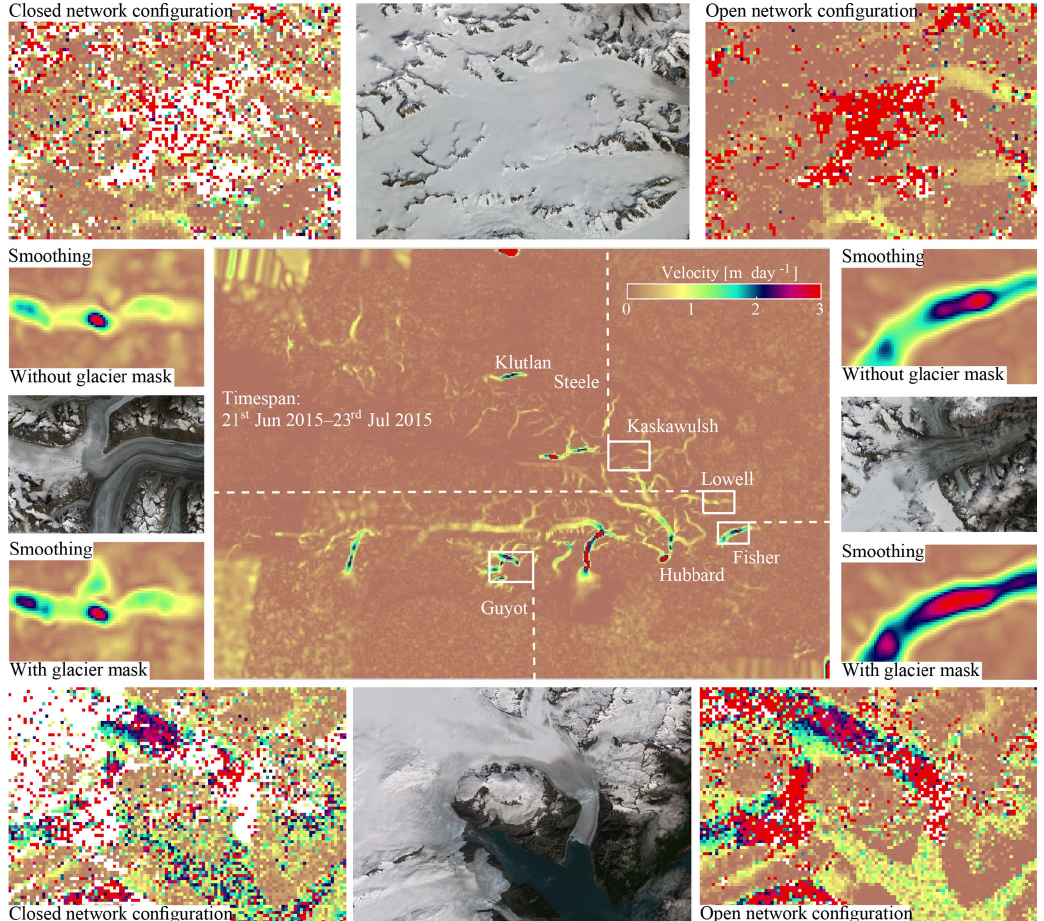
Figure 7. Overview map of different sections for the time interval, which is similar to Fig. 6 (i.e., 21 June till 23 July 2015). The surrounding zoom-ins are from the same time period but with different configurations (open vs. closed) or smoothing settings (glacier mask vs. no mask).